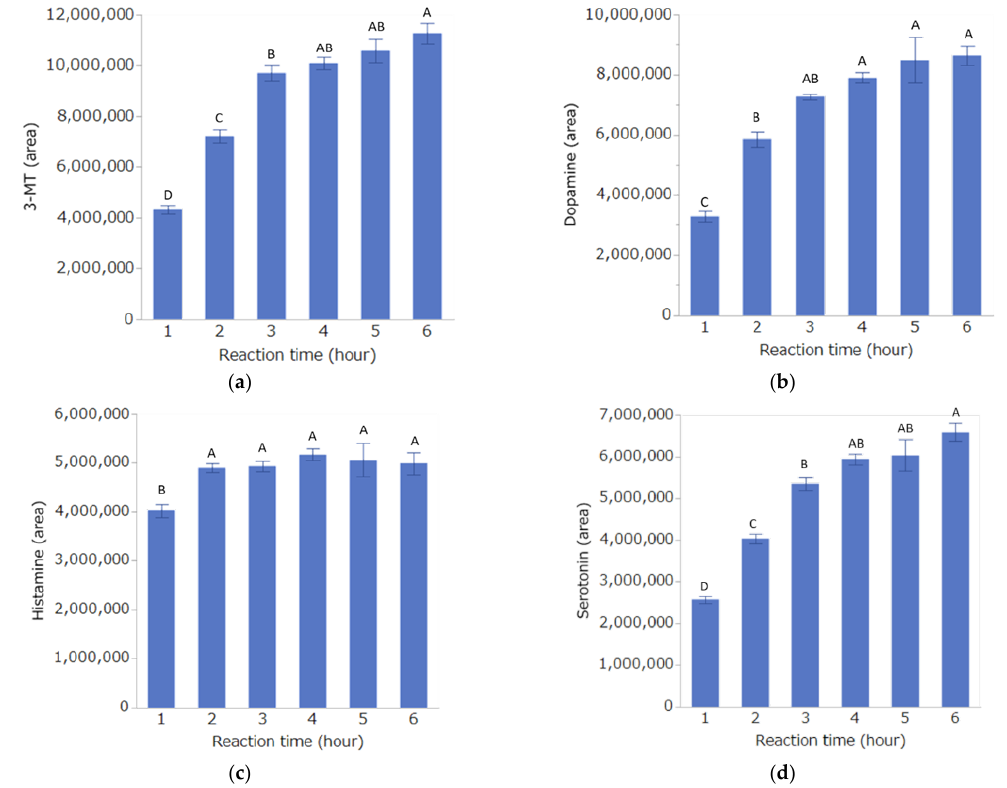
Figure 3. Effect of reaction time on derivatization with DPP. Detection of 3-MT ( a ), dopamine ( b ), histamine ( c ), and serotonin ( d ) by LC-MS/MS. Bar graphs indicate the mean ± SE of each condition ( n = 5 per condition). Different characters indicate significant differences, while identical characters indicate non-significant differences, as determined by Tukey-HSD tests. The results of the reaction temperature study are shown in Figure 4. The concentra-